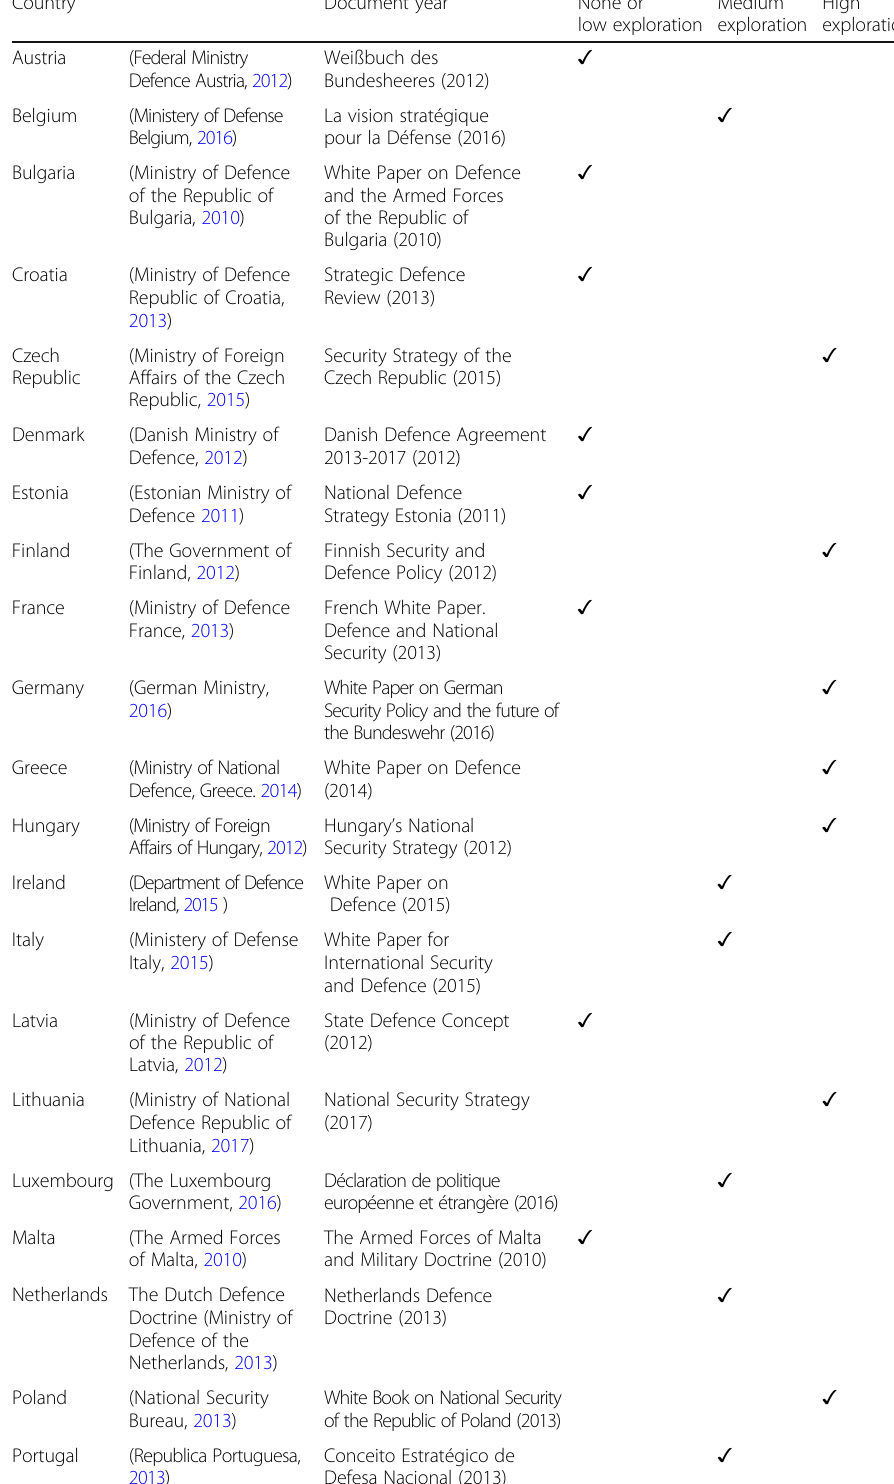
Table 1 Migration-security nexus in national security and defence